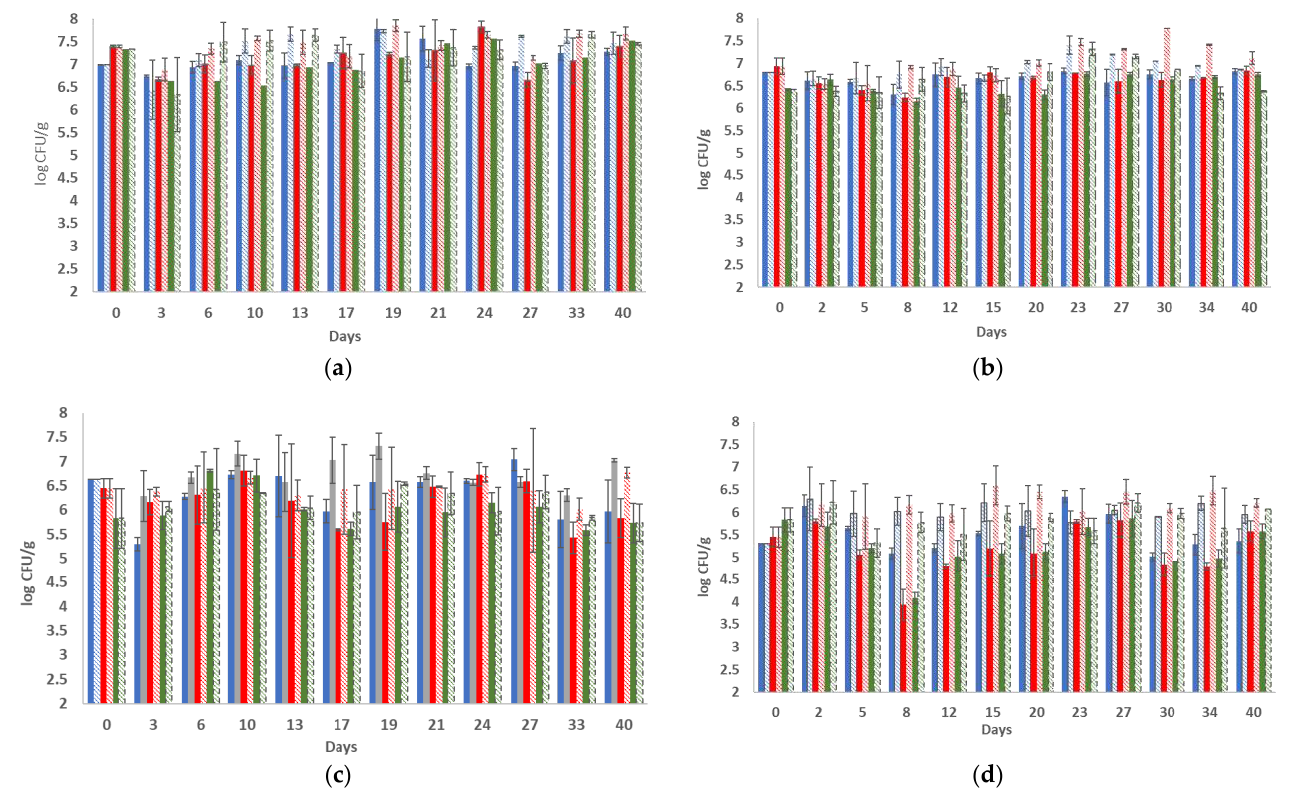
Figure 1. Population of total viable counts ( ■ ), mesophilic LAB ( ■ ) and lactococci ( ■ ) in control sample and population of total viable counts ( ) mesophilic LAB ( ) and lactococci ( ) in probiotic sample during storage of cheese slices at 4 °C without HPP (( a ) batch 1, and ( b ) batch 2) and with HPP (( c )—batch 1, and ( d )—batch 2). The bars represent the mean values ± standard deviations.